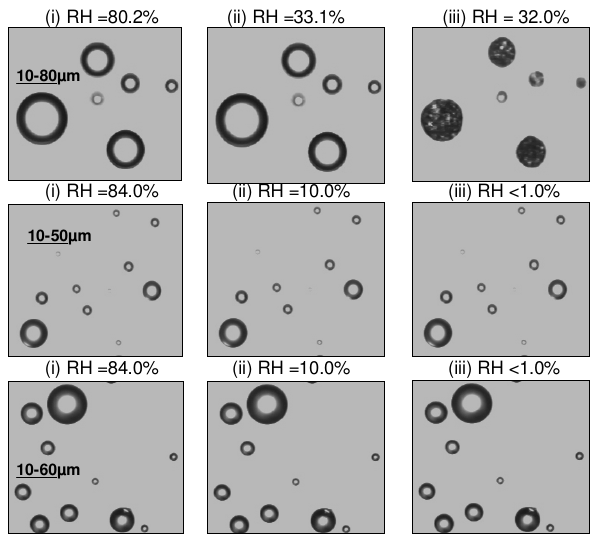
Fig. 11. A series of microscope images from the efflorescence ex- periments with droplets formed from crystals of (NH 4 ) 2 SO 4 (top), I 2 O 5 (middle), and HIO 3